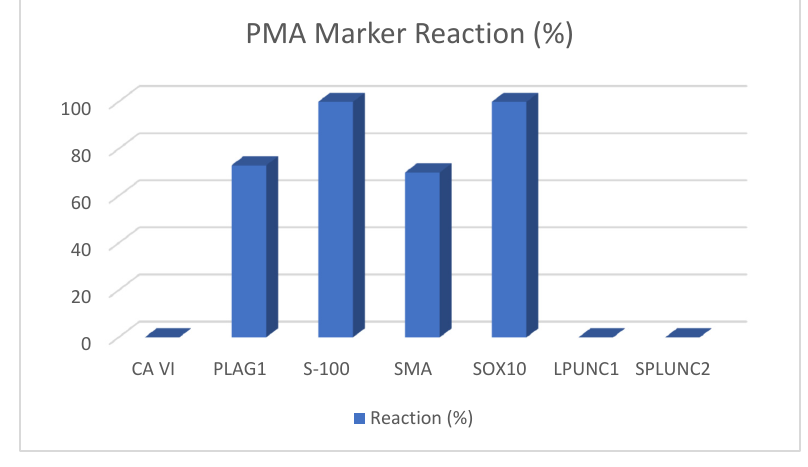
Figure 2. PMA marker reaction.